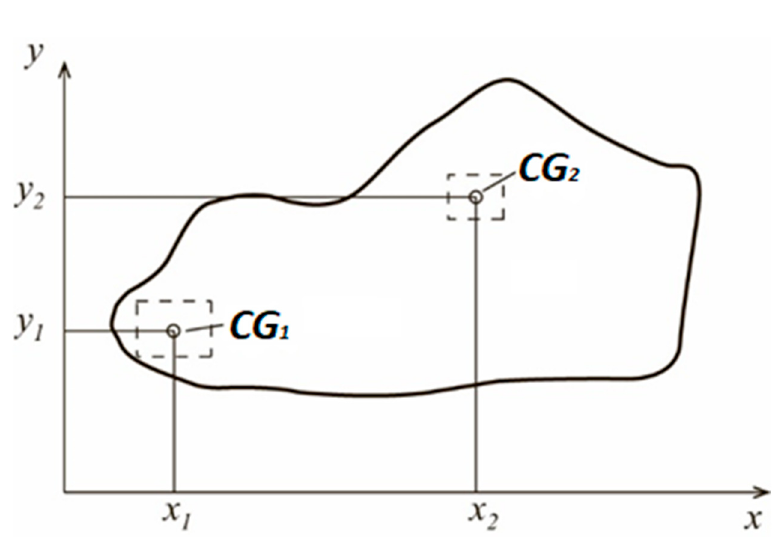
Figure 8. Scheme for determining CG of the defect zone.